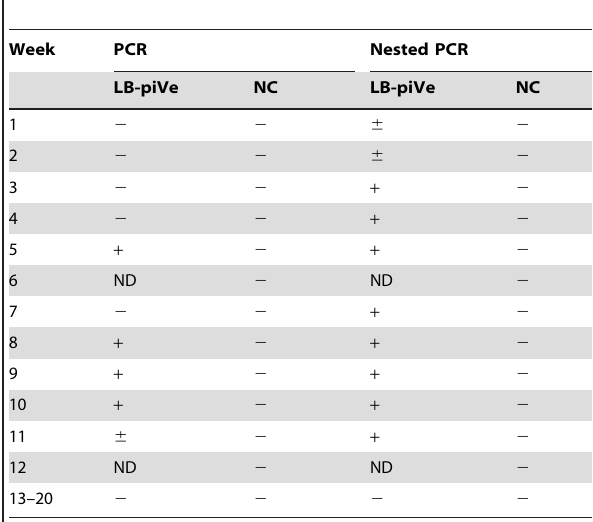
Table 1. HCV persistent infection in VeroE6